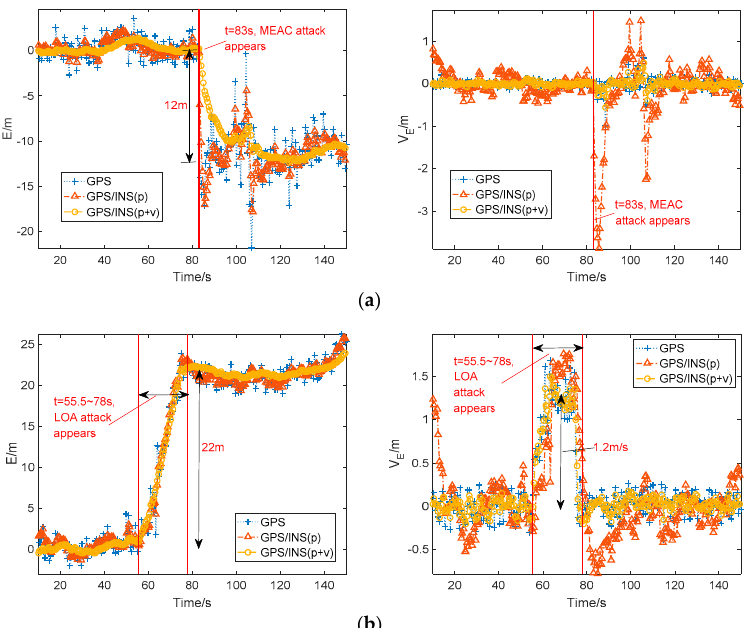
Figure 3. Eastern position error and eastern velocity estimated by Global Positioning System (GPS) and Global Positioning System /Inertial Navigation System (GPS/INS) under Meaconing attacks (MEAC) attack ( a ) and lift-of-aligned (LOA) attack ( b ). MEAC attack begins at 83 s and LOA attack is during 55 s to 78 s.